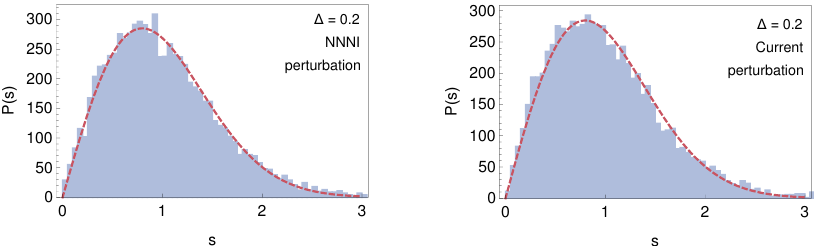
Figure 3: A typical level spacing distribution of a non-integrable system with the Wigner-Dyson distribution fitted (red dashed line). The left panel shows the case of = 0.1, while the right panel belongs to H H with L = 22 ∆ = 0.2 and g NNNI eff = L = 22, ∆ = 0.2 and g eff